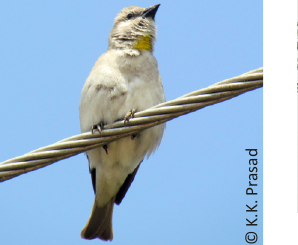
Image 74. Yellow-throated Sparrow Petronia xanthocollis